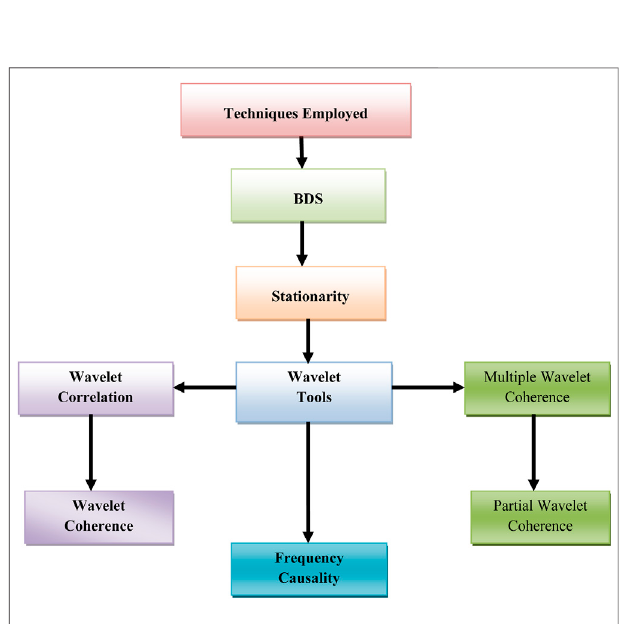
FIGURE 2 | Flow of